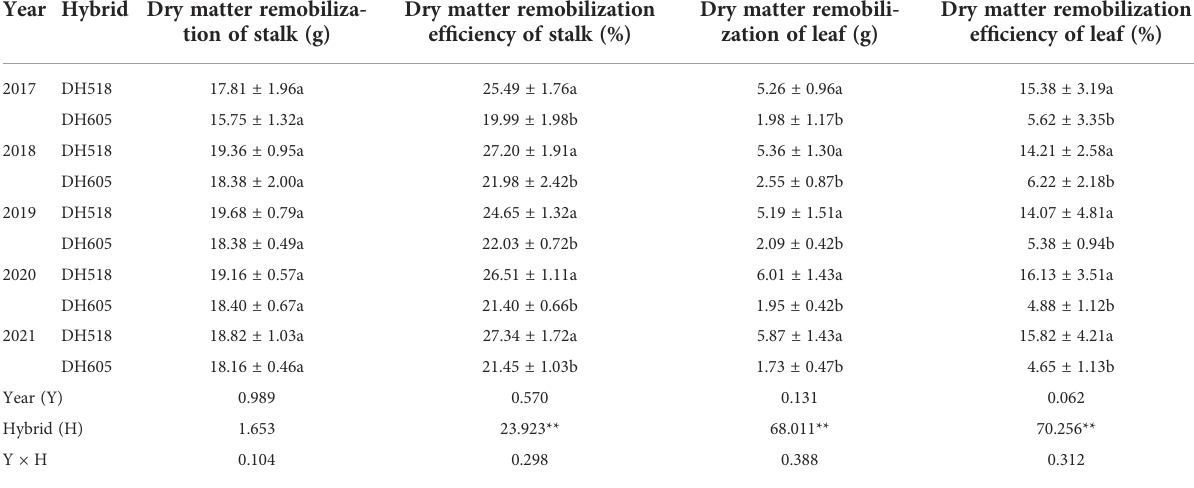
TABLE 3 Dry matter remobilization of vegetative tissues of summer maize hybrids with different growth duration from 2017 to 2021. Year Hybrid Dry matter remobiliza- tion of stalk (g)